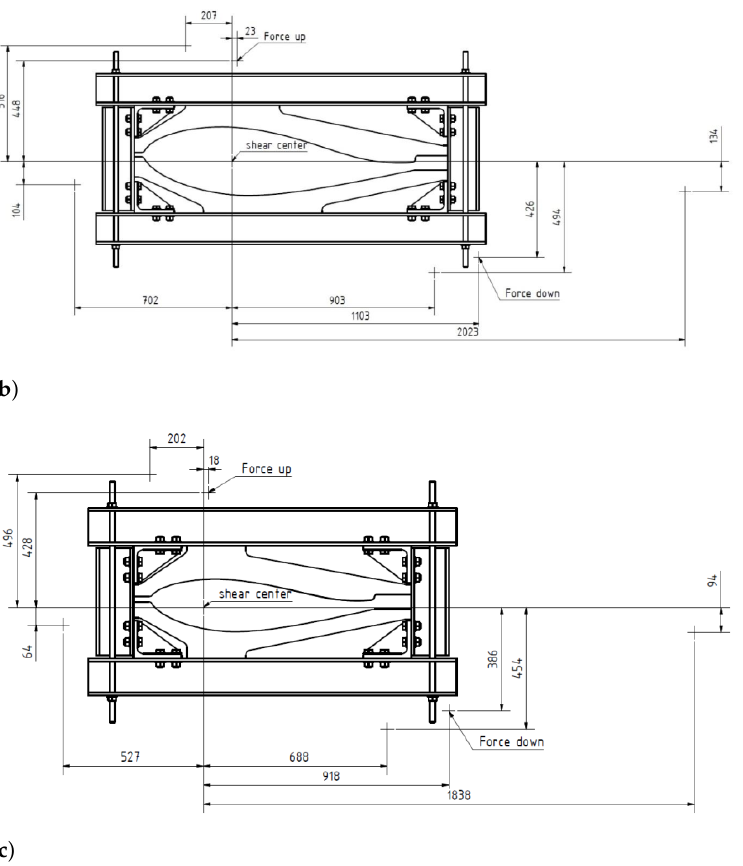
Figure A1. Load frames. ( a ) Torsion test LC1 load and optical measurement points. ( b ) Torsion test LC2 load and optical measurement points. ( c ) Torsion test LC3 load and optical measurement points.